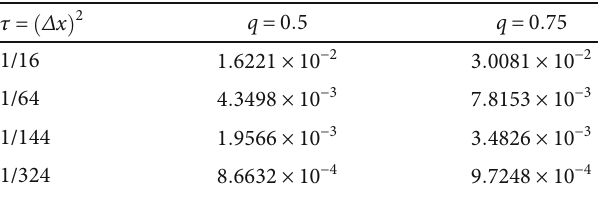
Table 4: The numerical results of the proposed scheme for Example 7 at T = 1 : 0